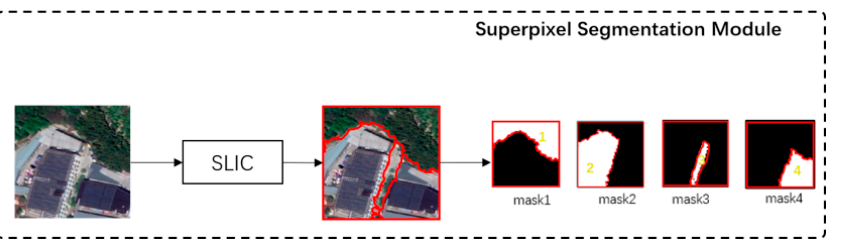
Figure 5. The structure of the superpixel segmentation module. The input is the image, and the outputs are masks.